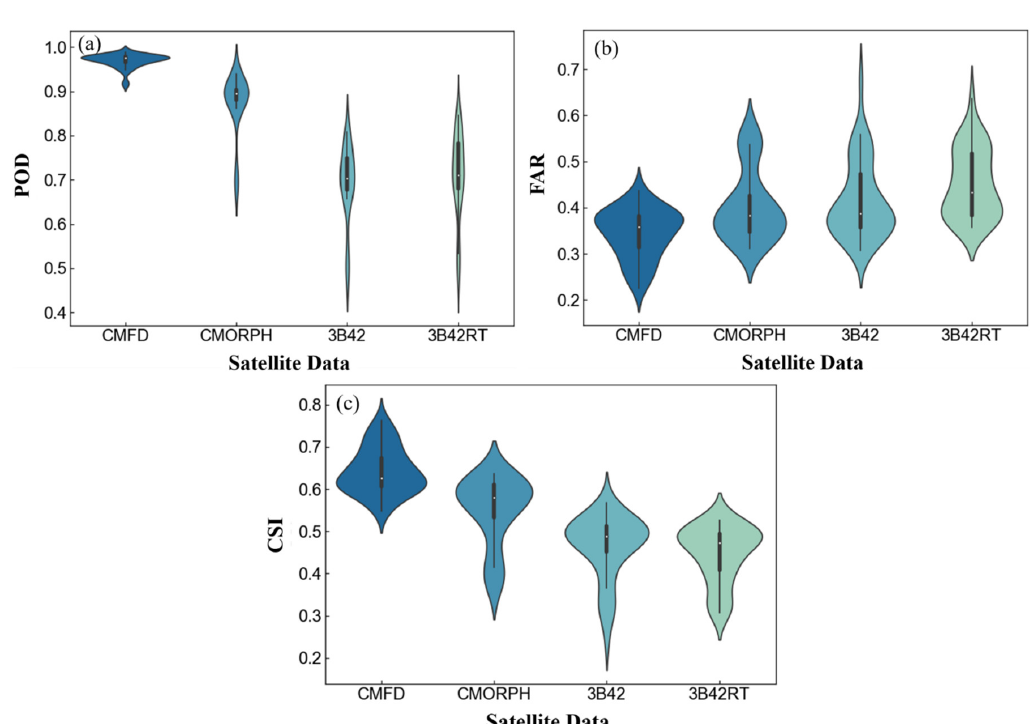
Table 5. Average monthly or seasonal statistical metrics for detection of precipitation at 36 stations in Beijing using four satellite-derived precipitation products.